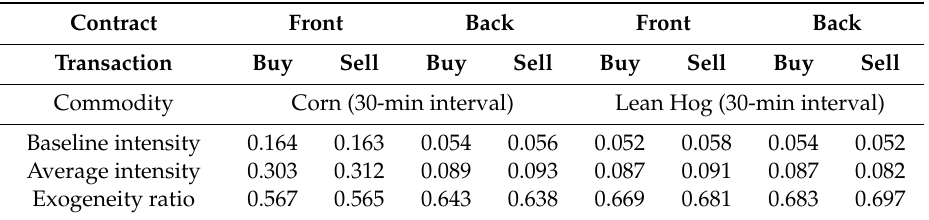
Table A1. Estimated baseline intensities, average intensities, and exogeneity ratios (corn, lean hog) for a 30-min interval.